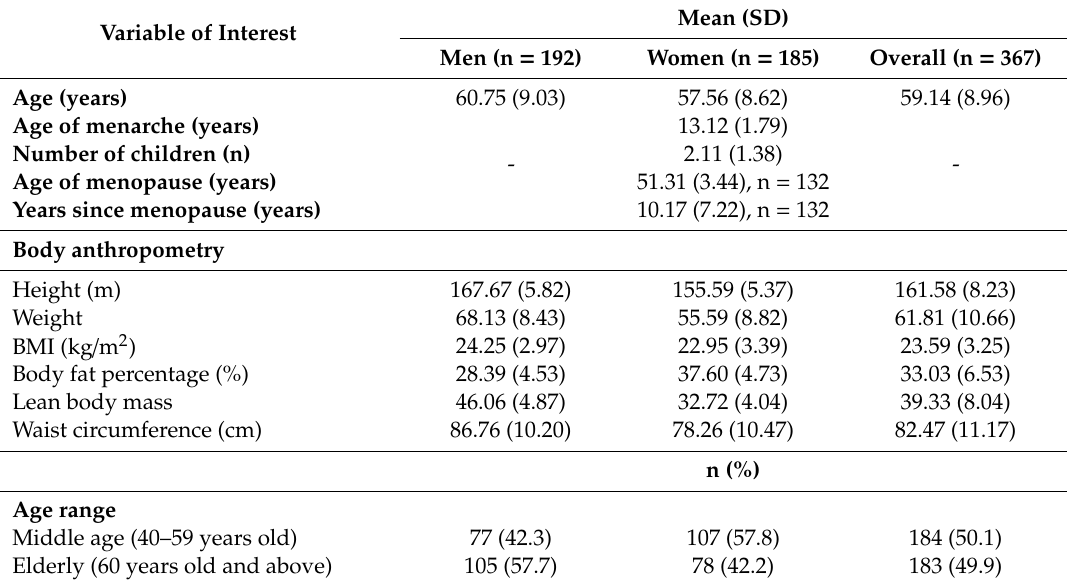
Table 1. Characteristics of